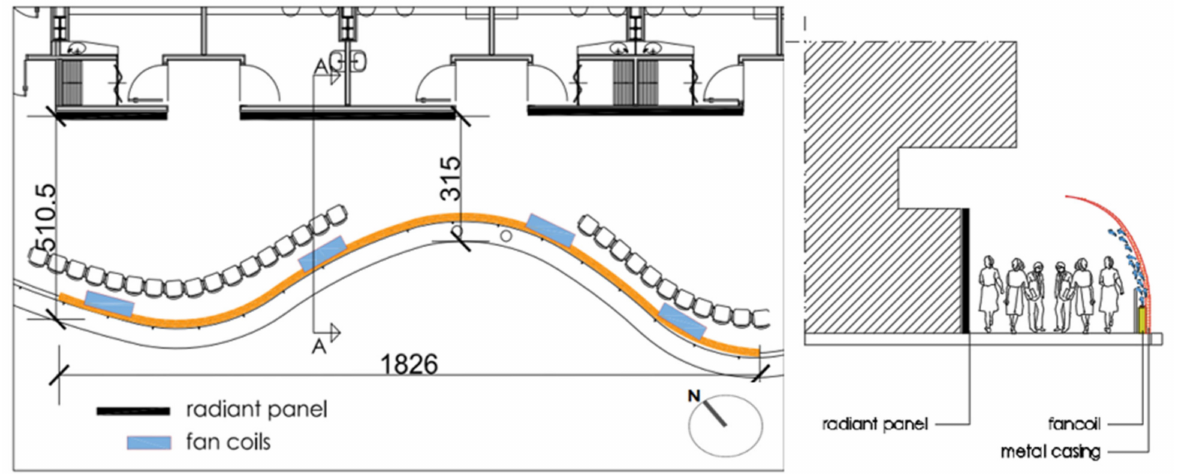
Figure 5. Plan of the intervention area on the left, section AA, on the right, showing the outpatient area and the technical solutions (fan coils, radiant panels, metal casing) proposed and analysed. The units of the quotas are in